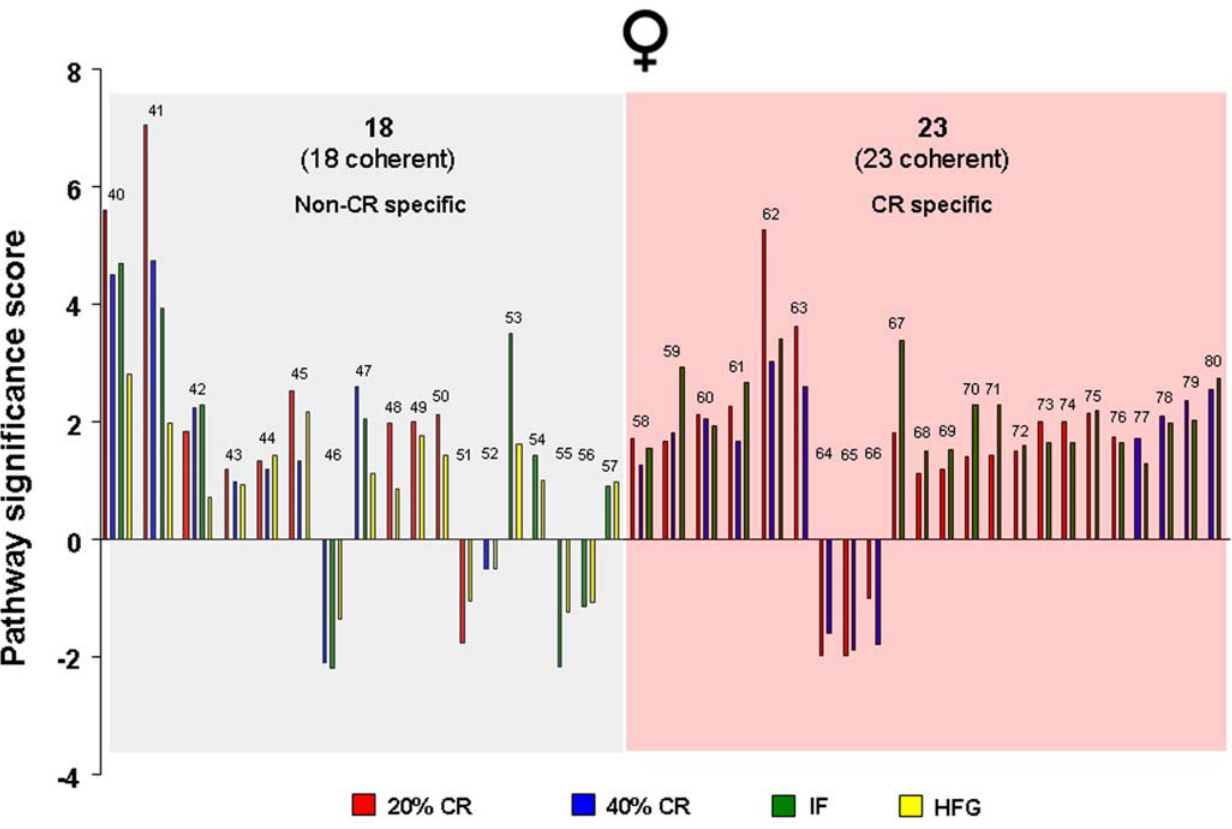
Figure 14. Females respond to dietary restriction and excess in an energy intake-dependent manner. The common-diet, significantly altered pathways in female hippocampi are summarized. More than half of the significantly altered gene pathways were common and coherent (altered in the same direction) between the energy restriction diets (20% CR, 40% CR, and IF), which suggests that the female hippocampal gene response to dietary manipulation is CR-dependent. Names of the significantly altered pathways can be found in Table